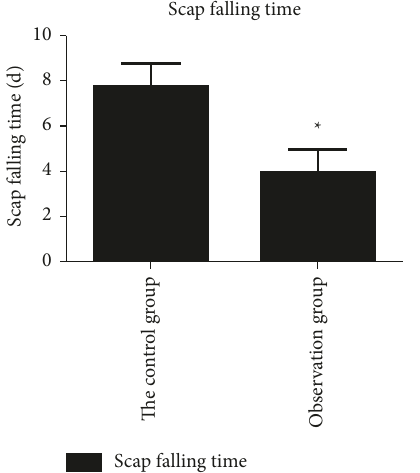
Figure 4: Comparison of the scab shedding time between the two groups. Note. Compared with the control group, t � 17.378, 21.059, and 8.465; ∗ P < 0 . 05.